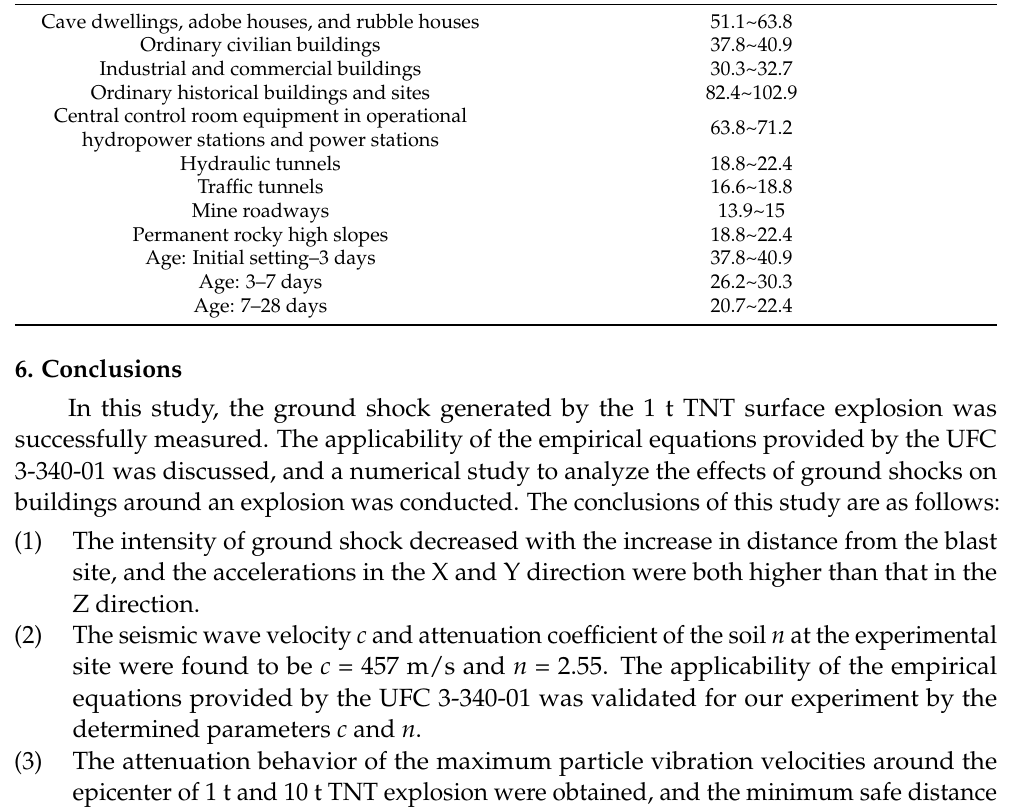
Table 8. Minimum distance for vibration safety of a 10 t TNT blast. To-Be-Protected